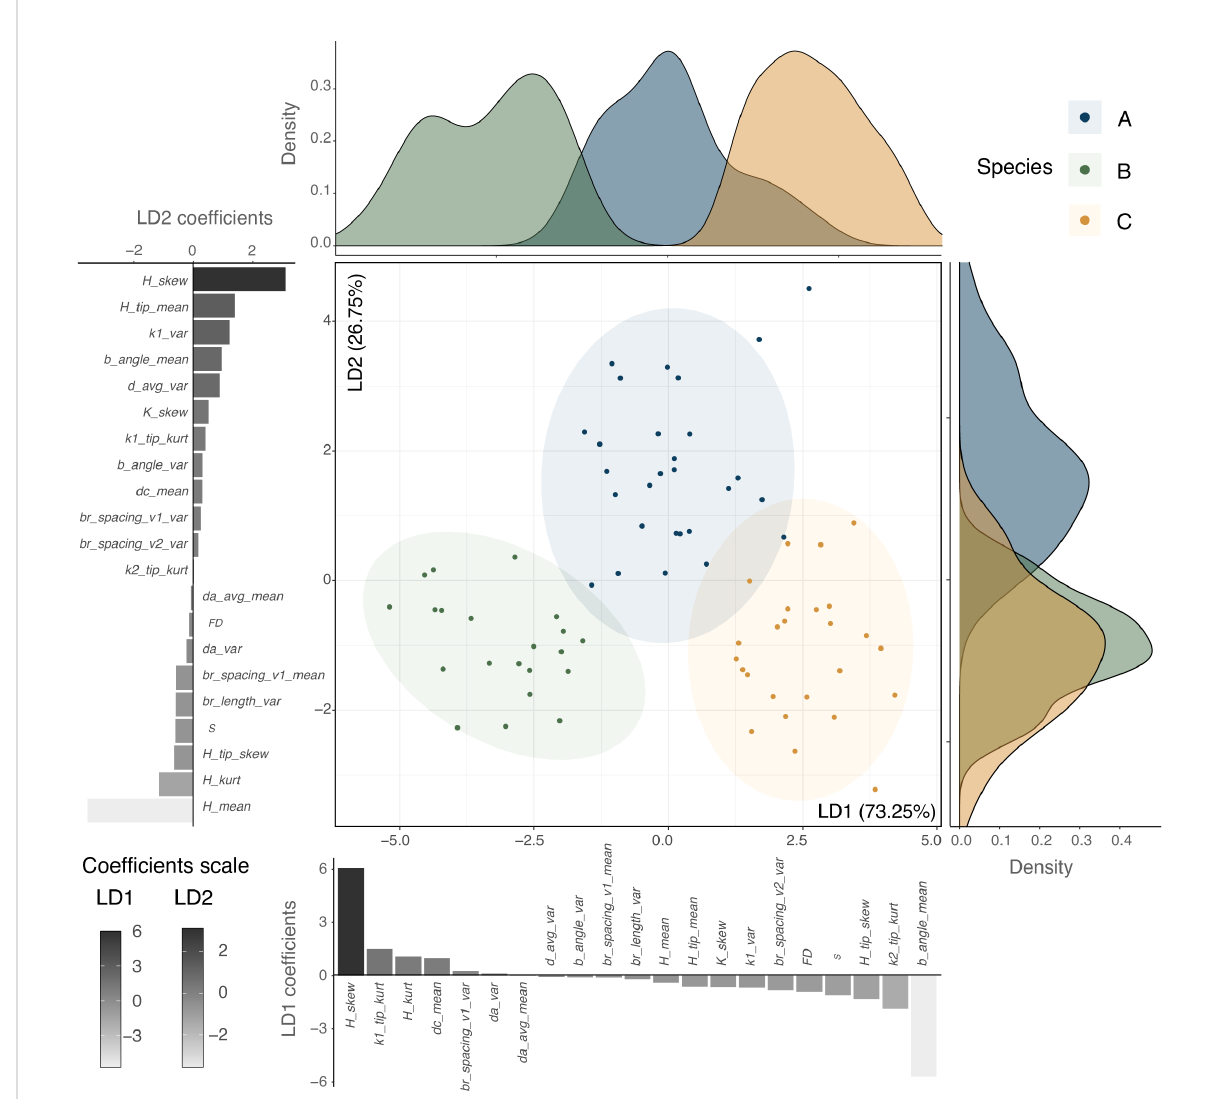
FIGURE 5 Discriminant multivariate analysis using a subset of variables. Linear discriminant analysis (LDA) using the variables that present no collinearity (Variance In fl ation Factor (VIF) < 10, 21 variables) displaying the percentage of trace for each main discriminant. Distribution densities for each one of the linear discriminants are plotted along the axes, along with the scaling coef fi cients for each